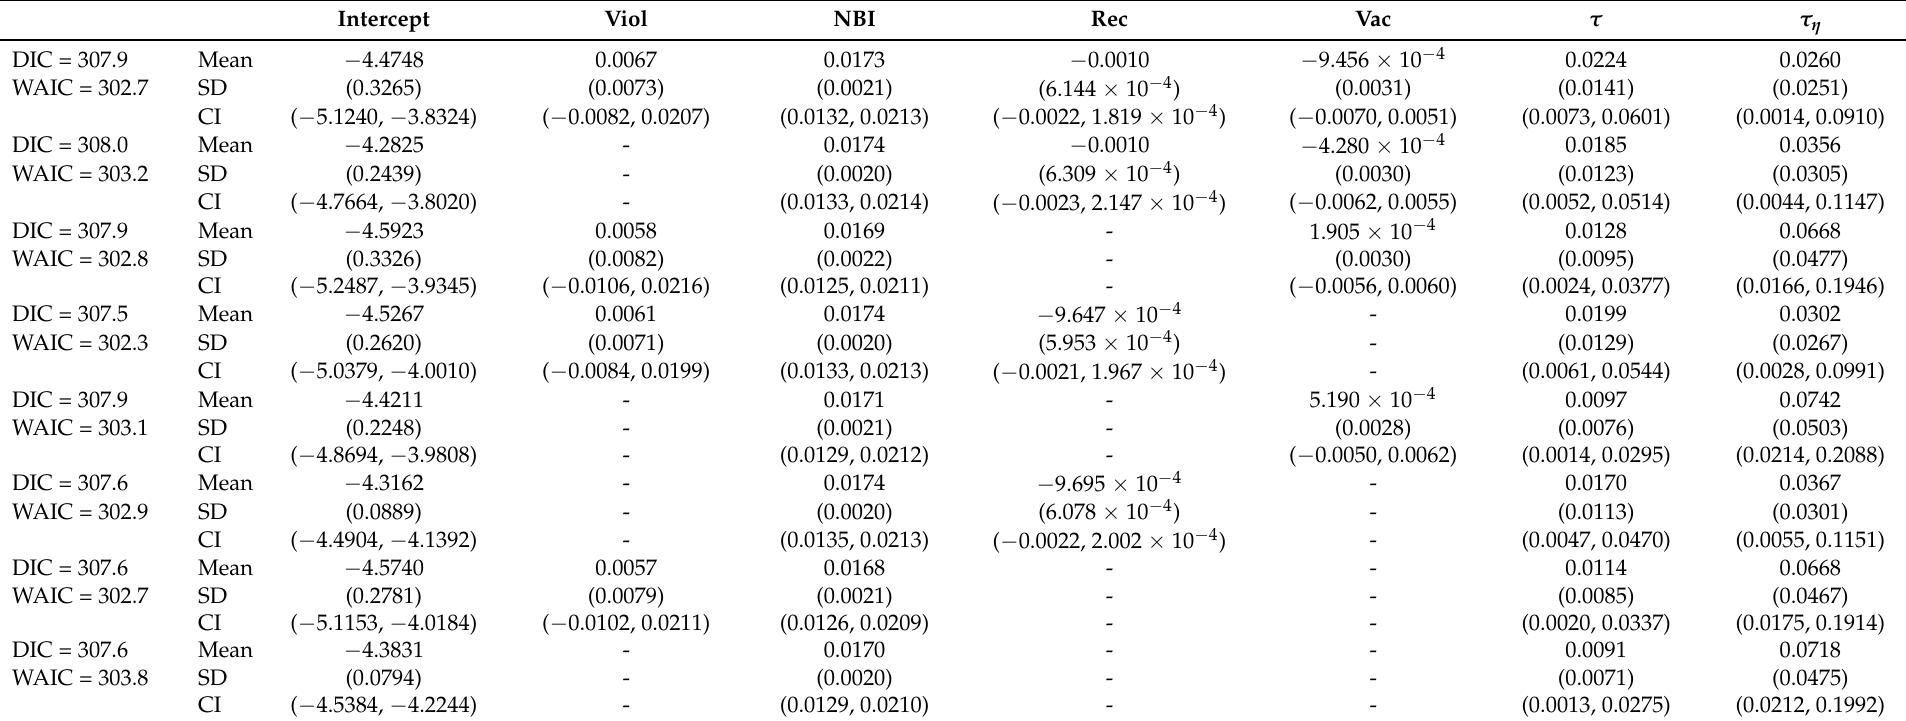
Table 9. Parameter estimates, standard deviations and 95% credible intervals for the estimated means in parenthesis, DIC and WAIC values for the reduced versions of the BYM model fitted in INLA to the Colombian infant mortality rates data